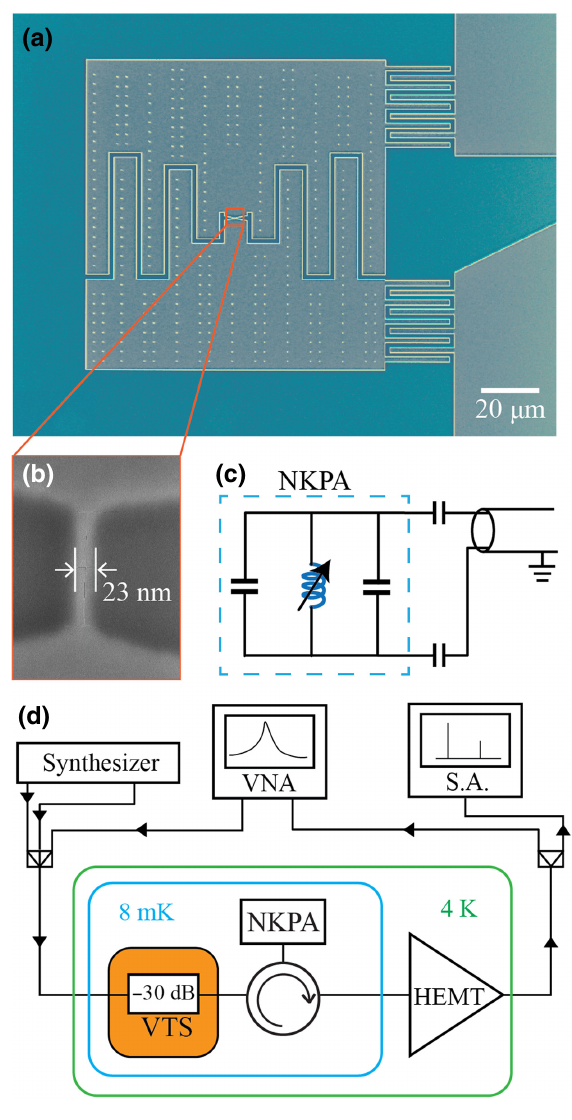
FIG. 1. (a) Optical image of the NKPA. The brighter area is NbN and the darker area is silicon substrate. As illustrated in (c), the resonator is constructed as a nonlinear inductor shunted by an interdigitated capacitor. The resonator is then coupled to a microwave transmission line via another set of interdigitated capacitors. (b) SEM image of the nanobridge. (d) Measurement setup diagram, with the NKPA cooled down to 8 mK. The vari- able temperature stage (VTS) serves as a known thermal source for noise calibration. VNA and SA stand for vector network analyzer and spectrum analyzer, respectively. HEMT stands for high-electron-mobility transistor, which is used as an